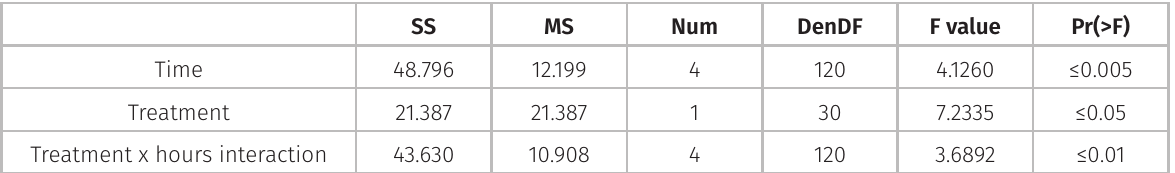
Figure 2. Mean preferred body temperatures (T ) and their standard p deviations during LPS- treatment or PBS-control over time (24h before and 2h, 24h, 48h, and 72h post-injection) for individuals of Liolaemus kingii . Dashed line indicates the mean T before